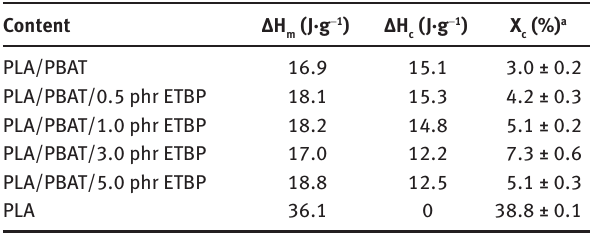
a For each sample, the test was performed three times under the same condition (at a rate of